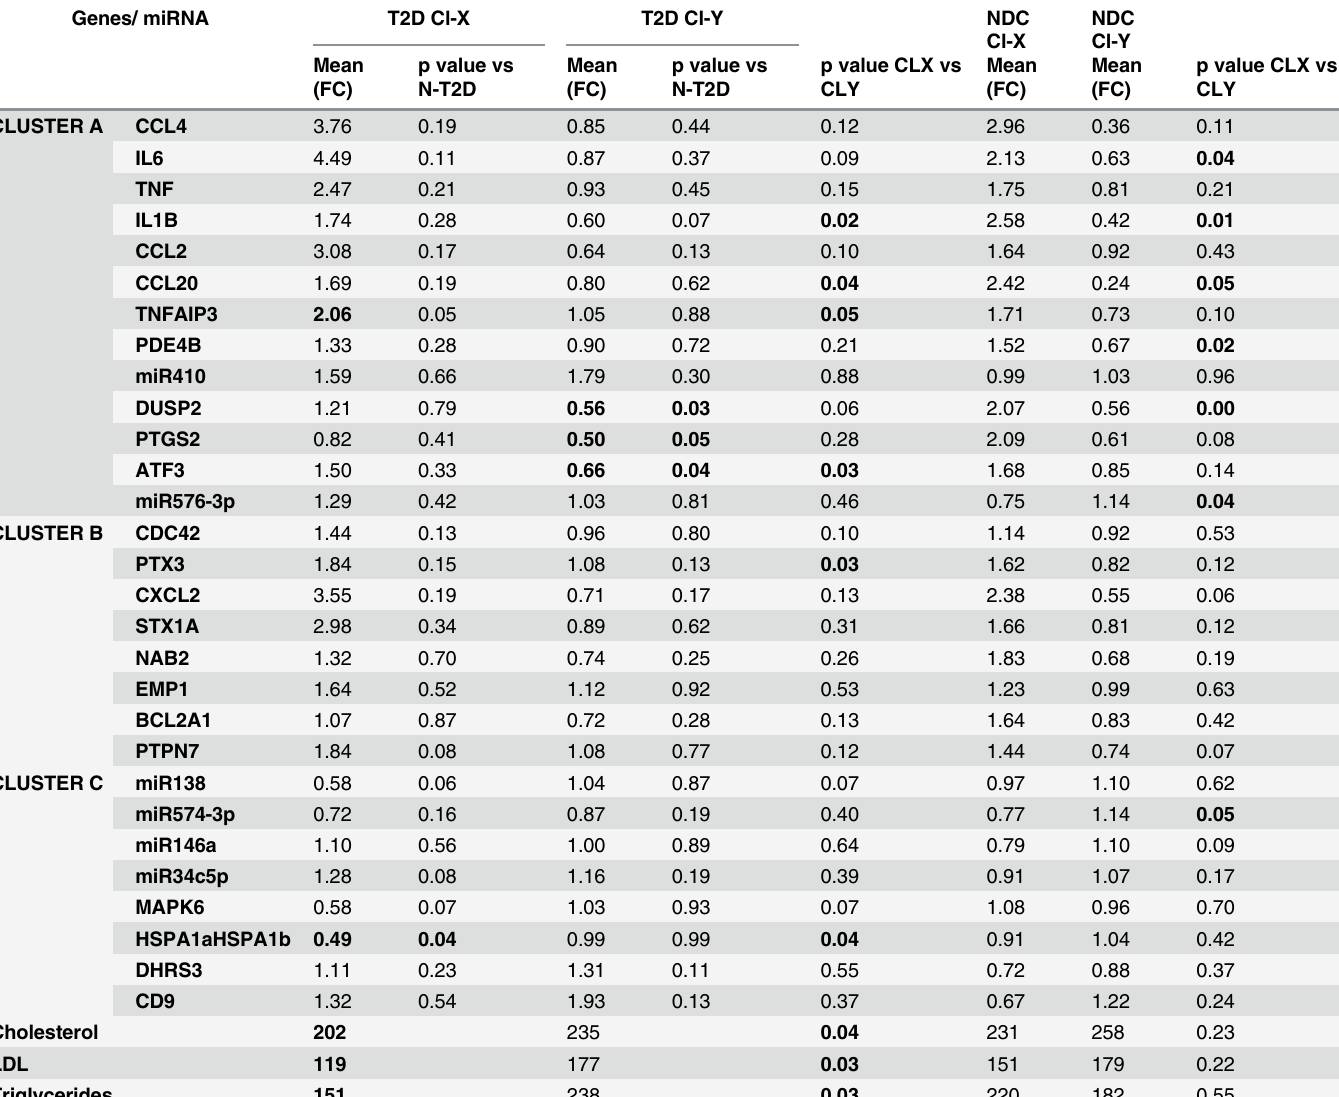
Table 2. Distinction of non-diabetic controls and T2D patients on the basis of dyslipidemia. Genes/